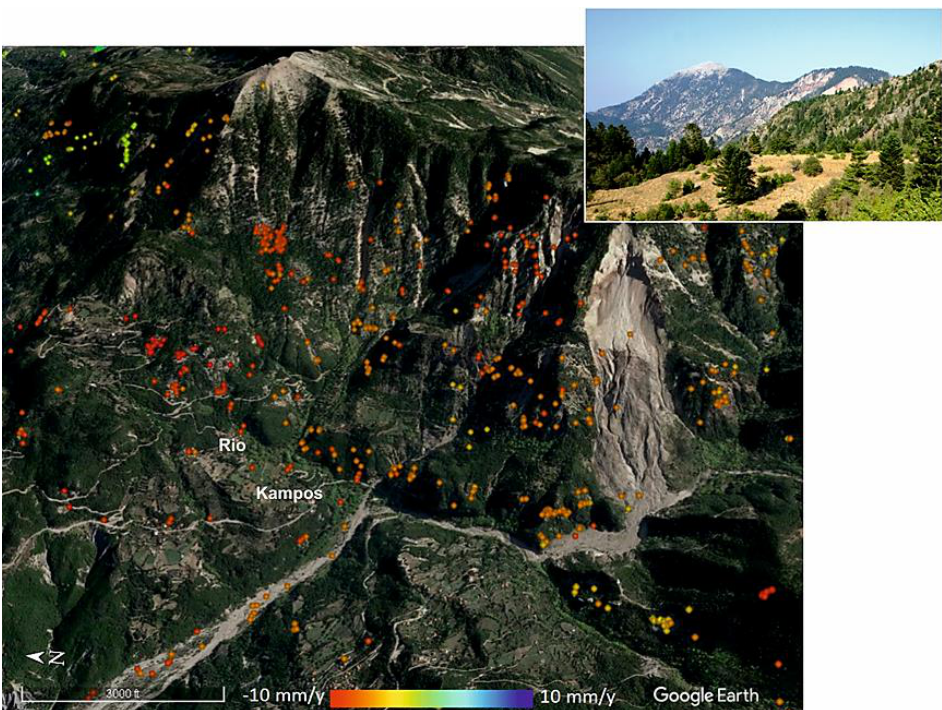
Figure 8. The entire slope is dominated by numerous debris flows threatening Kampos and Rio villages, Evritania Prefecture. The high deformation LOS velocity values, of the MTI data, ranging from 5 up to 11 mm/y, prove the dynamic conditions witnessed during the field champagne.